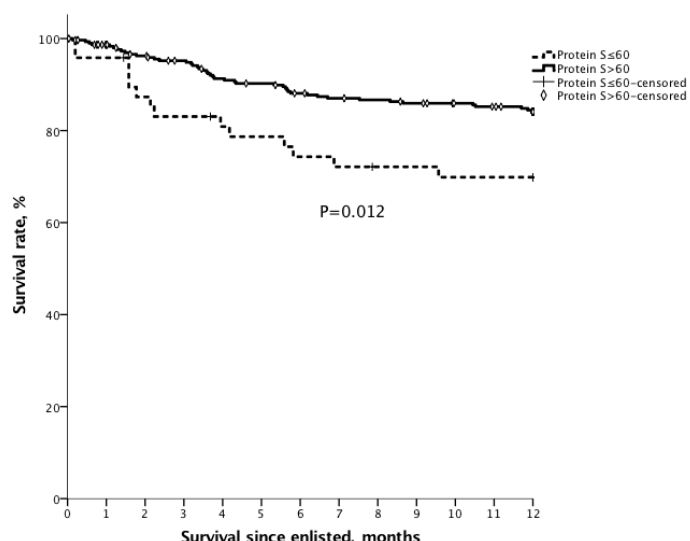
Figure 1. The Kaplan–Meier survival curve of the transplant recipients with or without PVT. The 1 year, 3 year and 5 year survival after transplantation for the patients with PVT were 90.3%, 71.0%, and 61.8%, compared with 86.1%, 76.2%, and 74.2% for the patients without PVT ( p = 0.956).